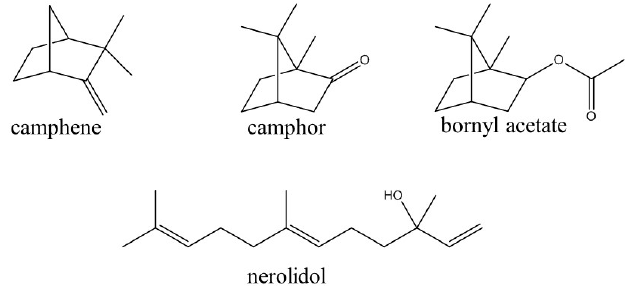
Figure 1. Chemical structures of volatile compounds isolated from the leaf essential oil of Piper mollicomum . Table 1. Chemical composition and retention indices of the constituents of P. mollicomum leaf essential